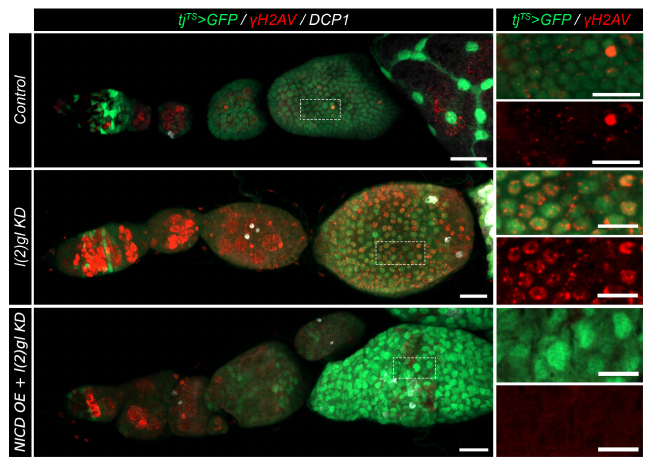
Figure 4. NICD overexpression protects from marks of DNA damage. Confocal images showing DNA damage marked with γ -H2AV antibody (red) in post-mitotic follicle cells (white box and ROI inset). Cell death is marked using DCP1 antibody staining (white). Scale bar = 10 µ